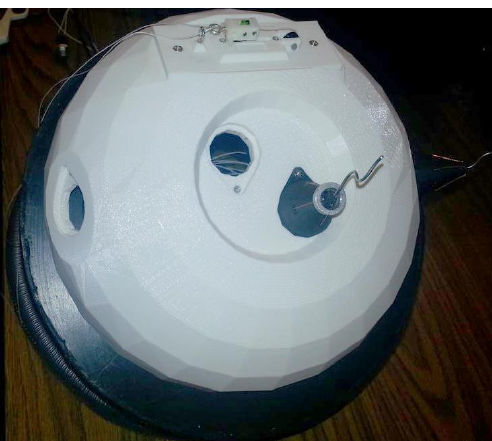
Figure 3: The integrated dome design is shown with Figure 1. The integrated dome design is shown with integrated knot integrated knot tying (top) and ring tower transfer (center- tying (top) and ring tower transfer (centerright) modules. right) modules.